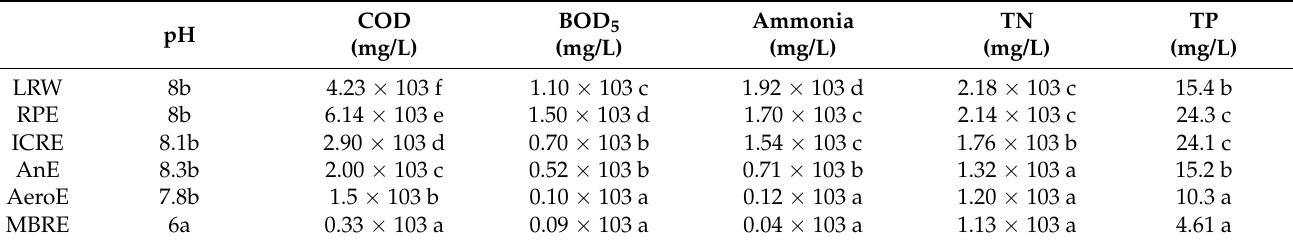
Table 2. Average values of leachate chemical parameters.